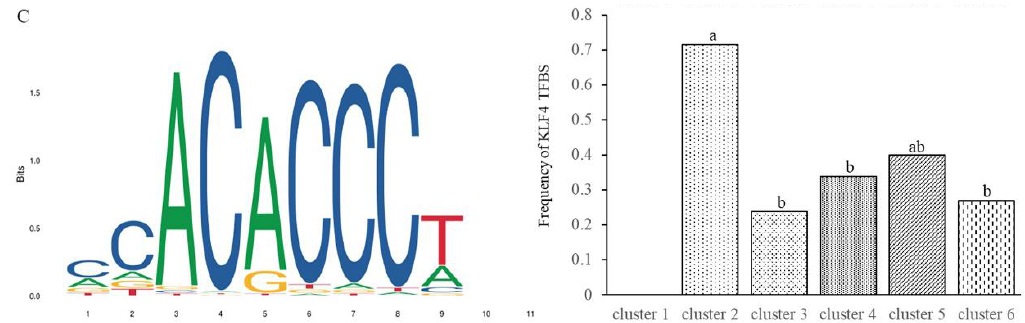
Figure 4. Occurrences of putative transcription factor binding sites (TFBSs) motifs of transcription factors ( A ) IRF8, ( B ) NFIL3, and ( C ) KLF4 in the promoter regions of various gene clusters. Bars with different letters (a, b, ab) indicate significant differences at the significance level of α = 0.05.